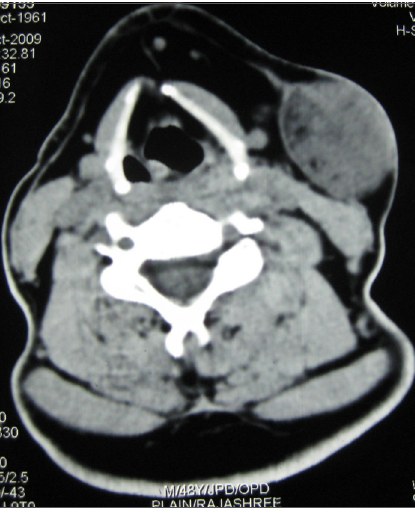
Figure 1. ct scan (axial ) - ct scan showing a 3.2x4.2 cm soft tissue density with tiny densities of fat attenuation. lesion is seen displacing the